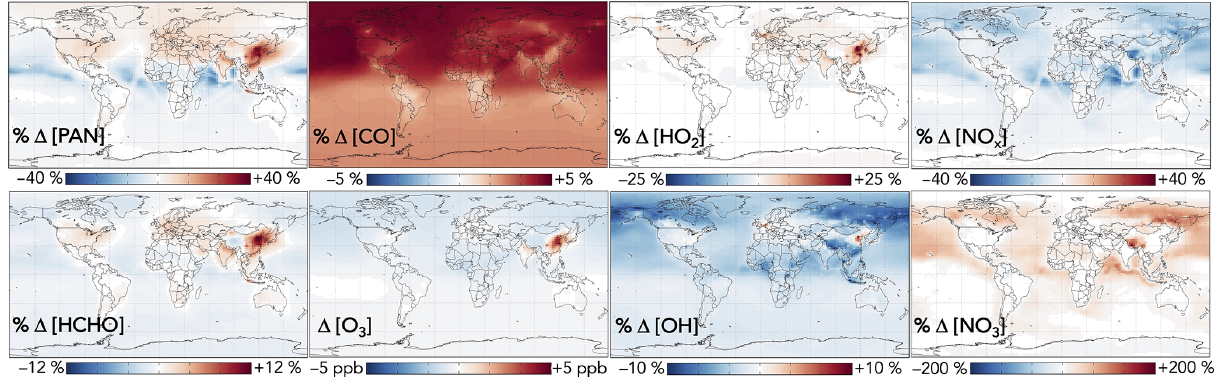
Figure 11. Effects of GC13 aromatic chemistry on PAN, formaldehyde, CO, ozone, HO 2 , OH, NO x , and NO 3 concentrations. Panels show the absolute (for ozone) and relative (for others) differences in annual mean concentrations below 1km altitude between GEOS-Chem simulations with GC13 aromatic chemistry and with no aromatic chemistry. The color scales are